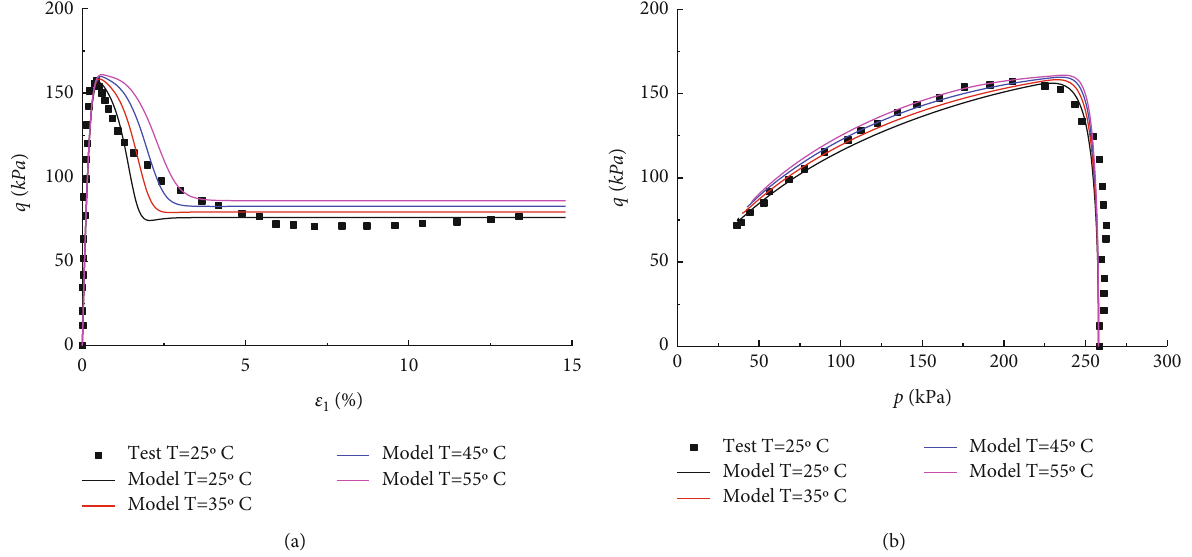
= 0 : 98 ): (a) stress-strain relationship; r 0